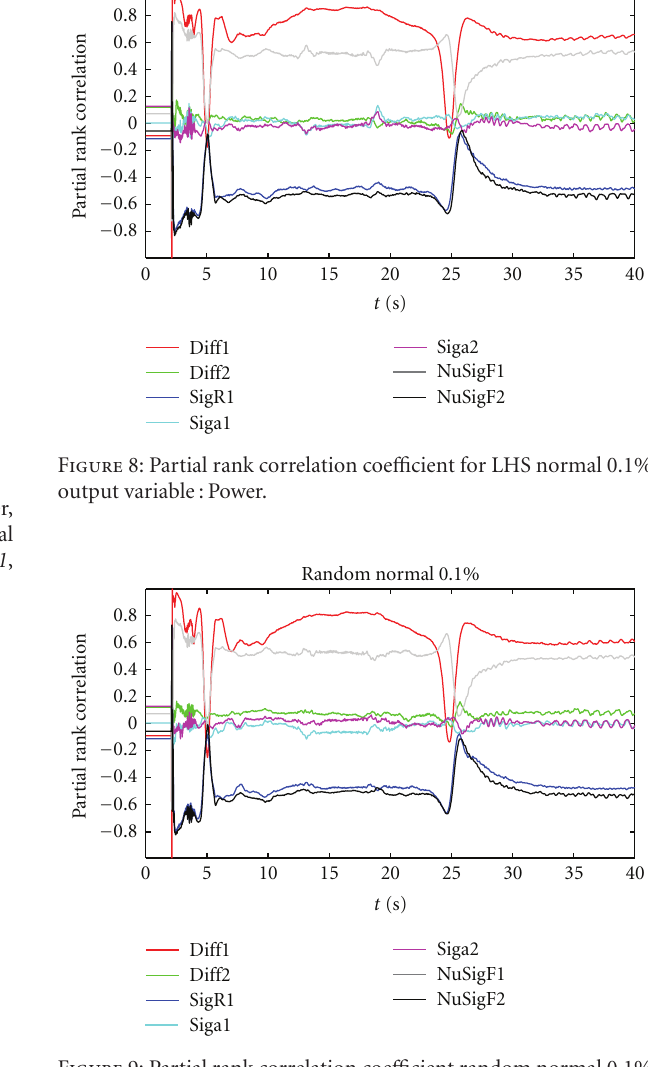
Figure 9: Partial rank correlation coe ffi cient random normal 0.1%, output